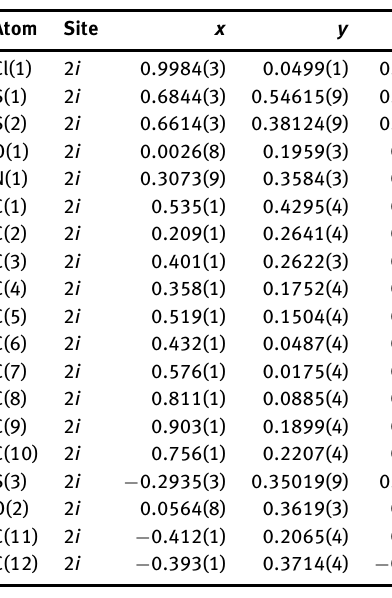
Table 3: Atomic displacement parameters (Å 2